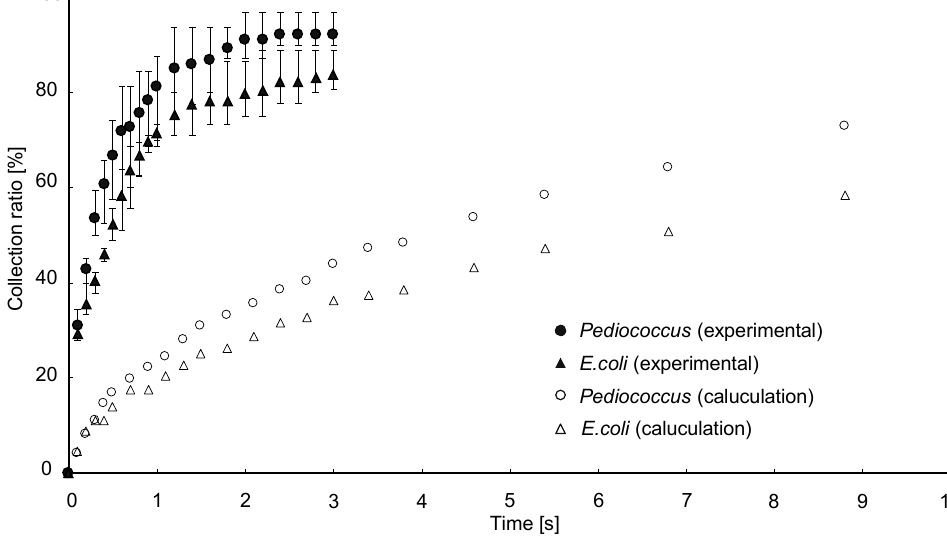
Figure 7. Time variation in the number of captured bacteria: measurements were performed at least three times to confirm reproducibility. The trapping amount saturates at a value of more than 80% in about 2 s.